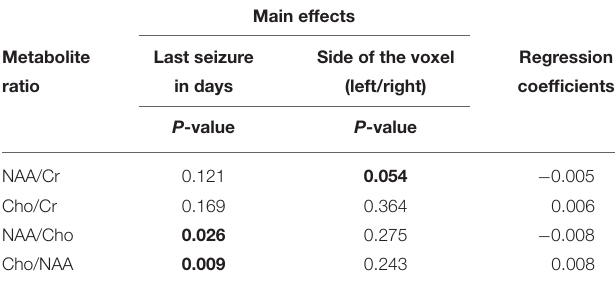
TABLE 4 | Significant positive correlation found between N-acetylaspartate (NAA)/choline (Cho) ratio ( P = 0.03) and Cho/NAA ratio ( P = 0.01) and time span from last seizure and the acquisition of magnetic resonance spectroscopy (MRS) in comparison to the control group with relation to the side of the voxel. Calculated regression coefficients show how the metabolite ratio increases [NAA/creatine (Cr), NAA/Cho] and decreases (Cho/Cr, Cho/NAA) over